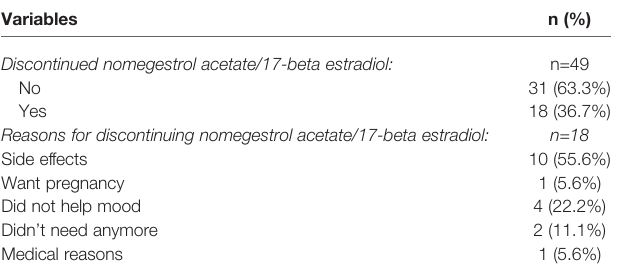
TABLE 4 | Adherence to nomegestrol acetate/17-beta estradiol and potential side effects for non-adherence at time 2 of interview. Variables